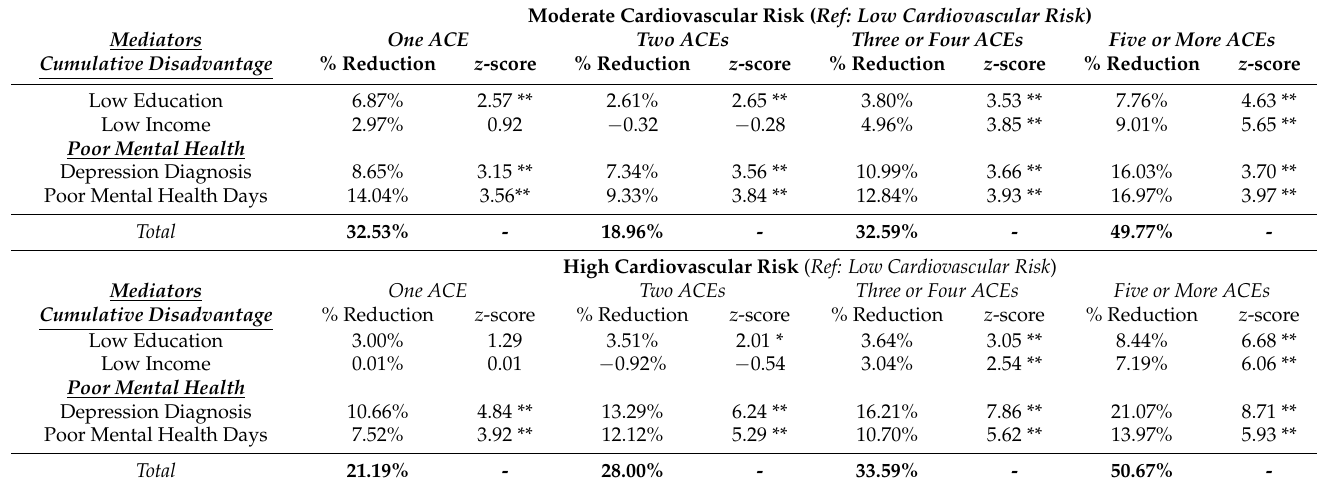
Table 3. KHB test of mediators between ACE exposure and young adult cardiovascular